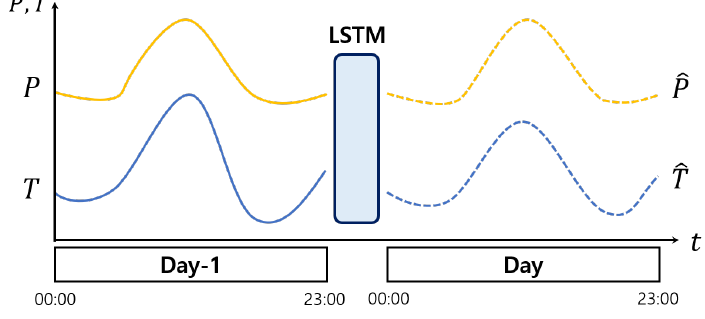
Figure 3. Forecasting the load demand and temperature using only past data.